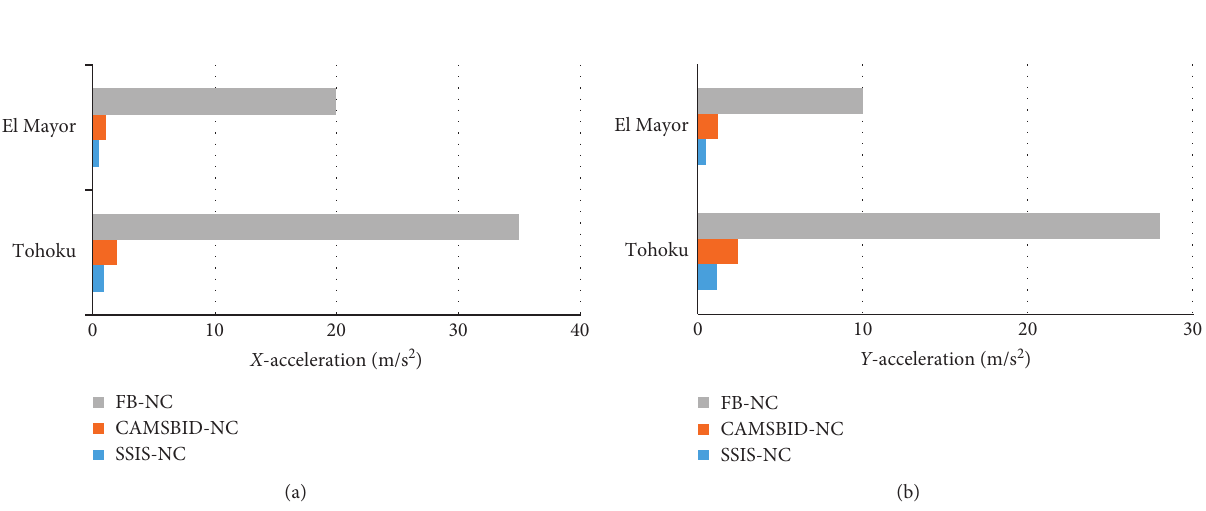
Figure 17: Peak top-level acceleration responses of the SSIS-NC, CAMSBID-NC, and FB-NC structures.